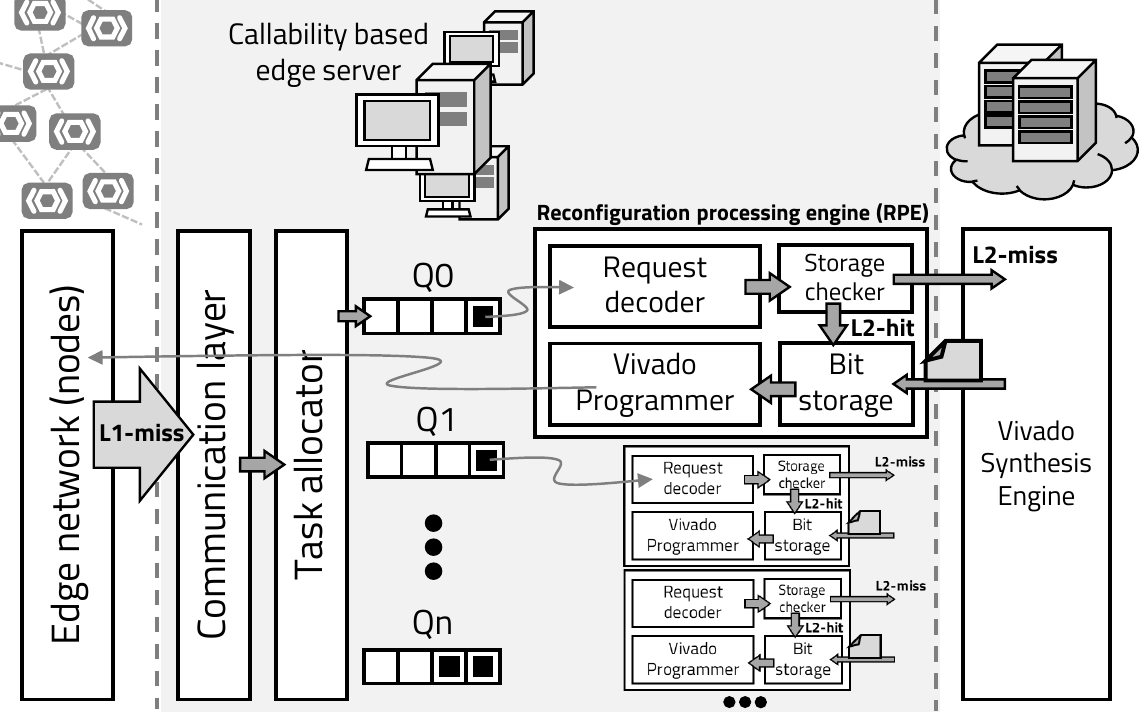
Figure 6. mIoT server